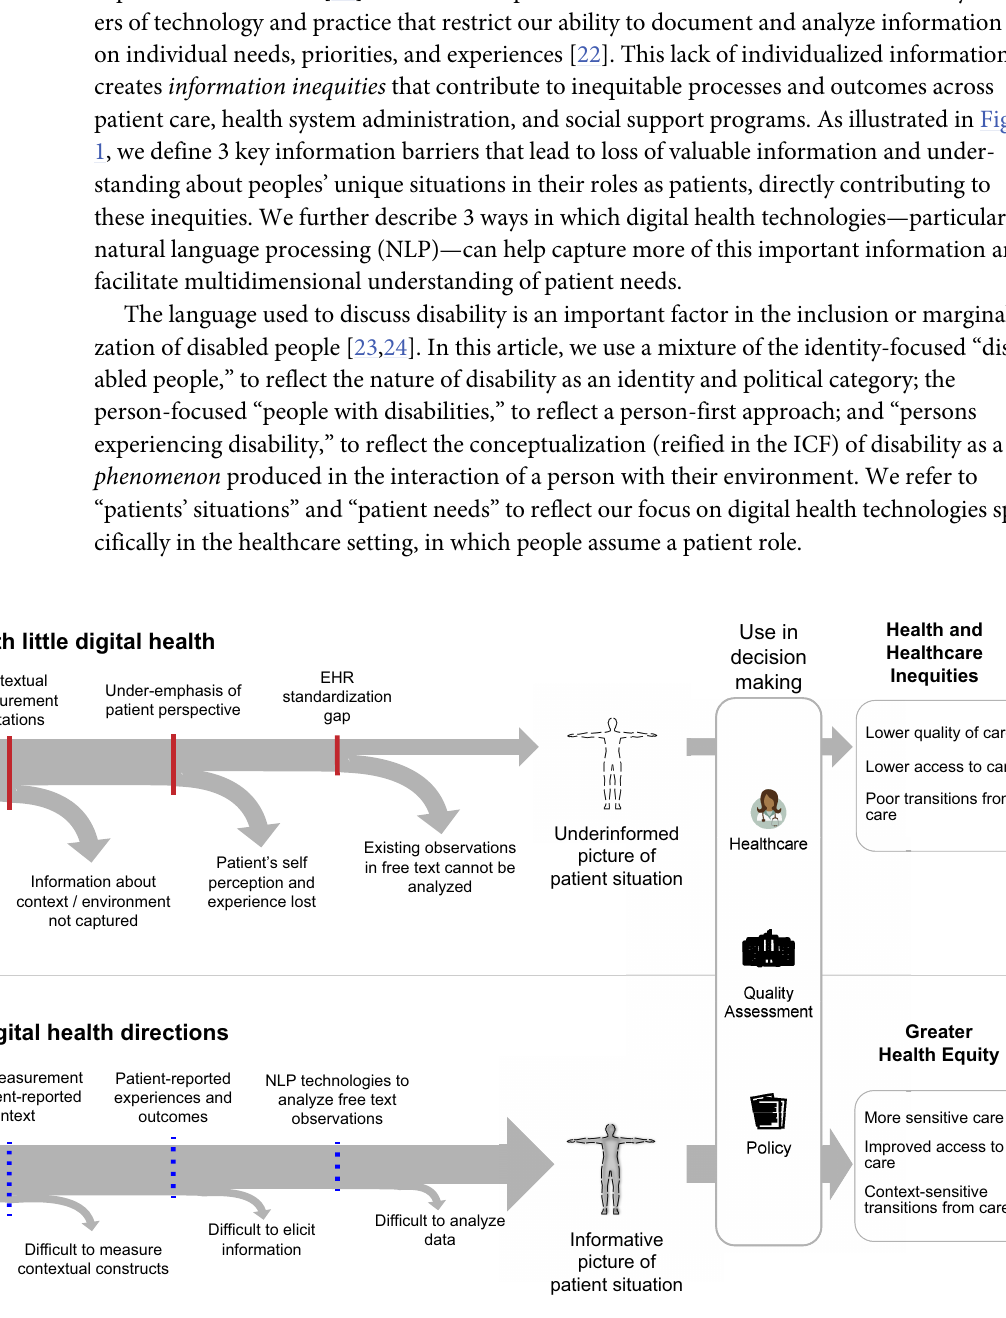
PLOS Digital Health | https://doi.org/10.1371/journal.pdig.0000135 November 17,